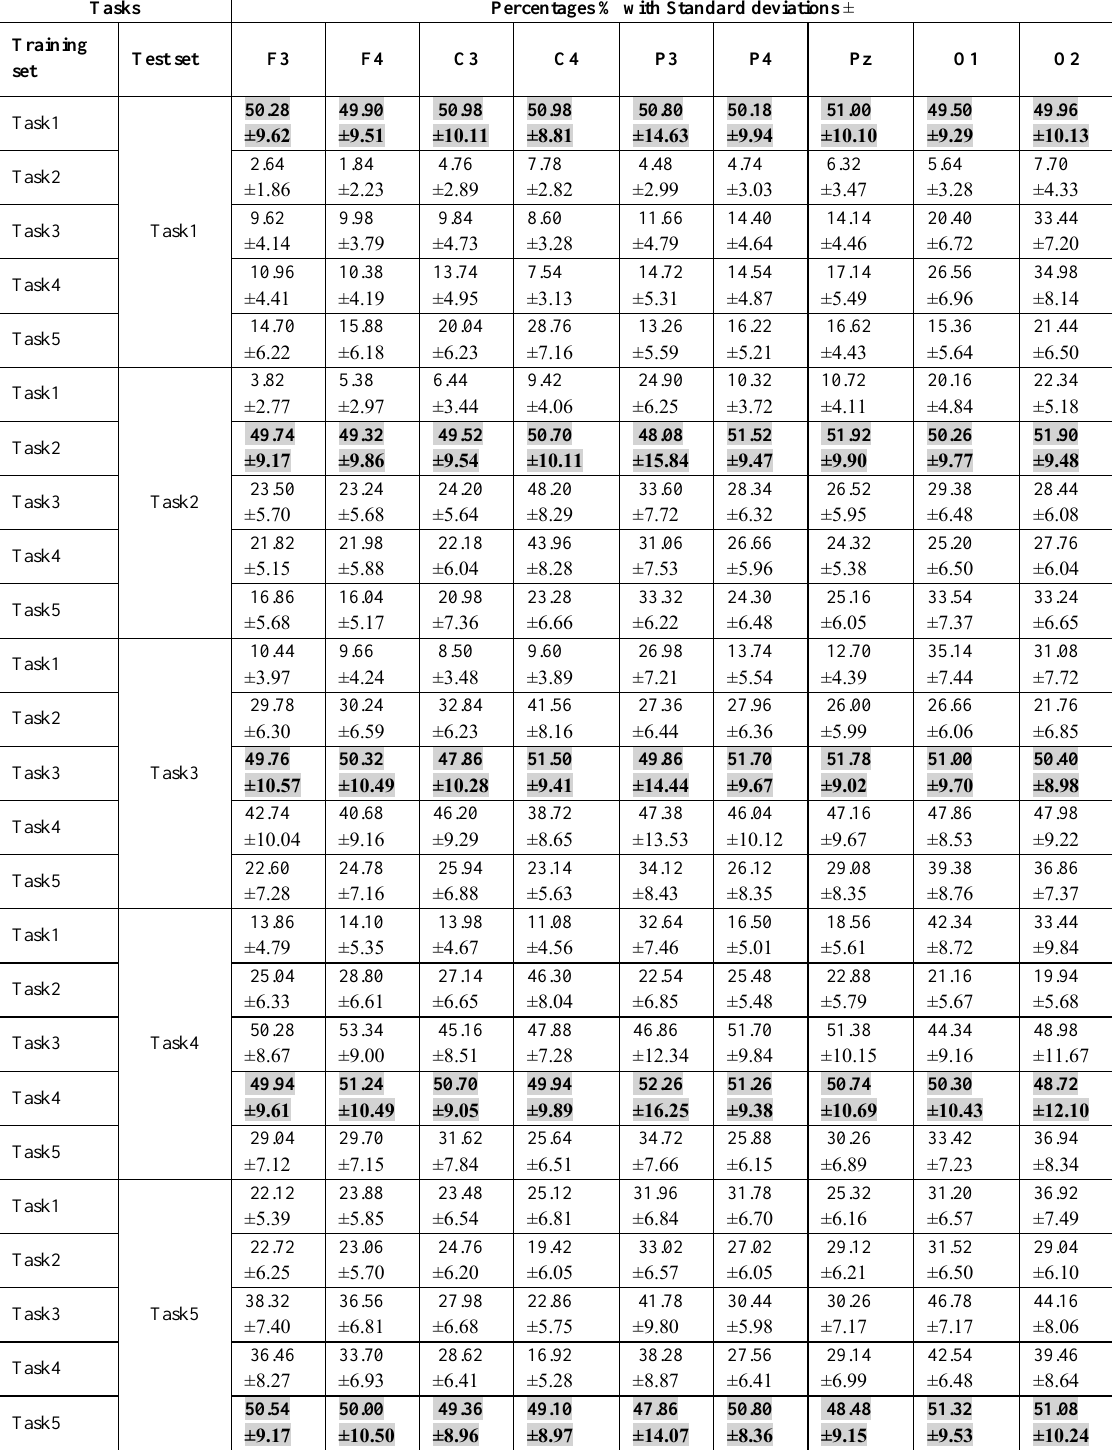
Table 1. Proposed final class label decision